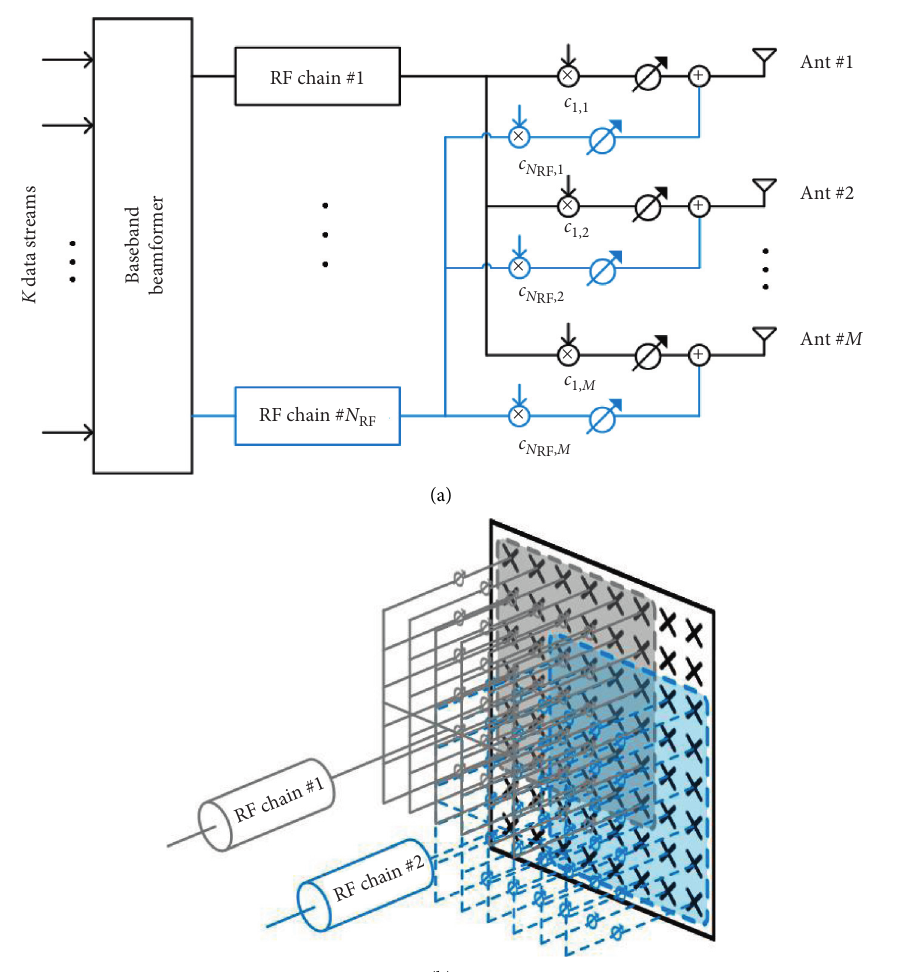
Figure 3: Two-dimensional overlapped partially connected subarray structure: (a) RF chain connection; (b) v � 6 and h � 6 subarray